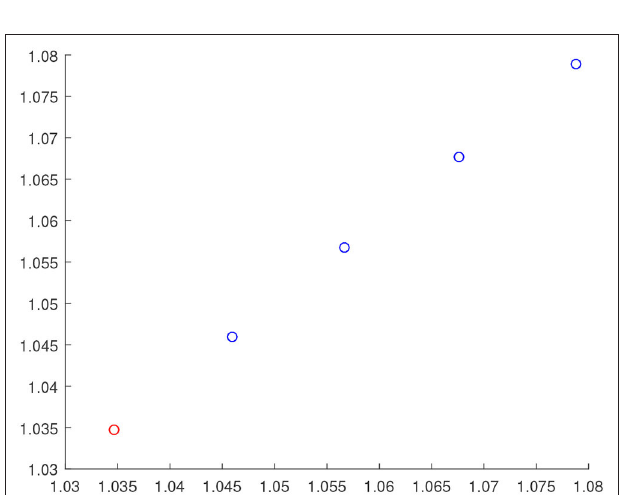
FIGURE 12 | The position information of the vehicle when the formation is stable.